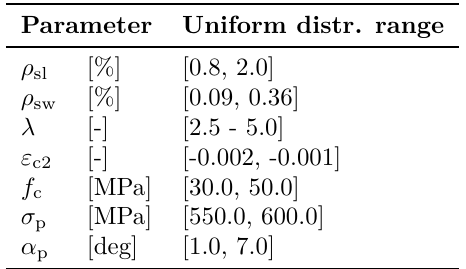
Table 1. Input parameters for sensitivity